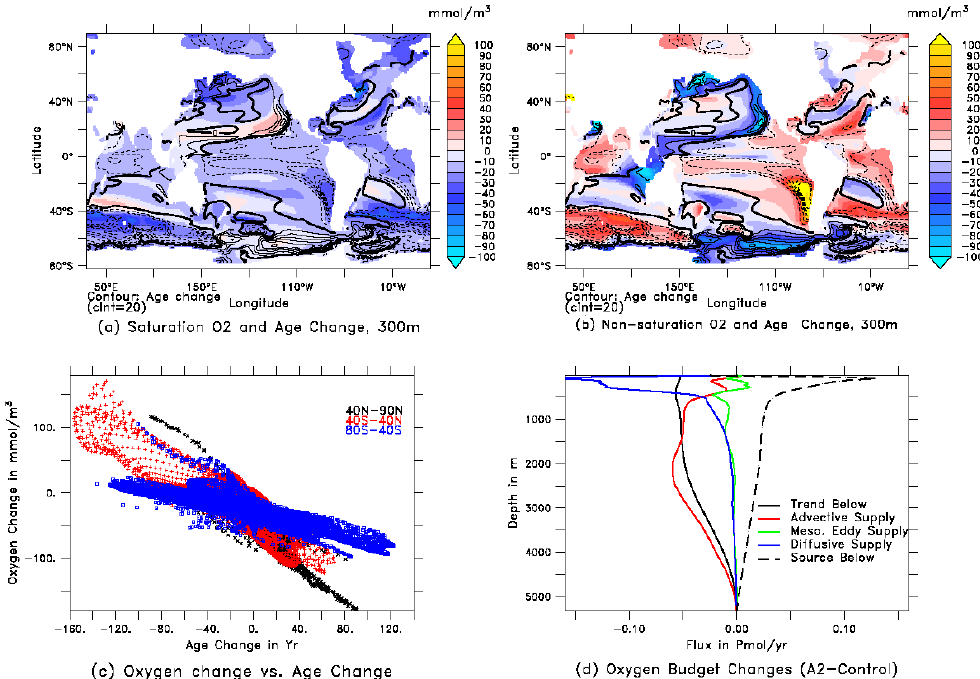
Fig. 3. (a) Change in the O 2 saturation in in µM at 300m from years 2281–2300 under the A2 scenario relative to corresponding years in the 1860 Control scenario. Primarily due to change in temperature. Contours of the change in ideal age in years are overlaid (dashed contours negative, solid contours positive, bold contour zero line, contour interval=20yr). (b) Change in the O 2 concentration at 300m in µM at years 2280–2300 with oxygen saturation effects removed and ideal age change overlaid. Note the correspondence between regions that are getting older/younger and less/more oxygenated. (c) Scatterplot of O 2 change vs. age change. (d) Change in the O 2